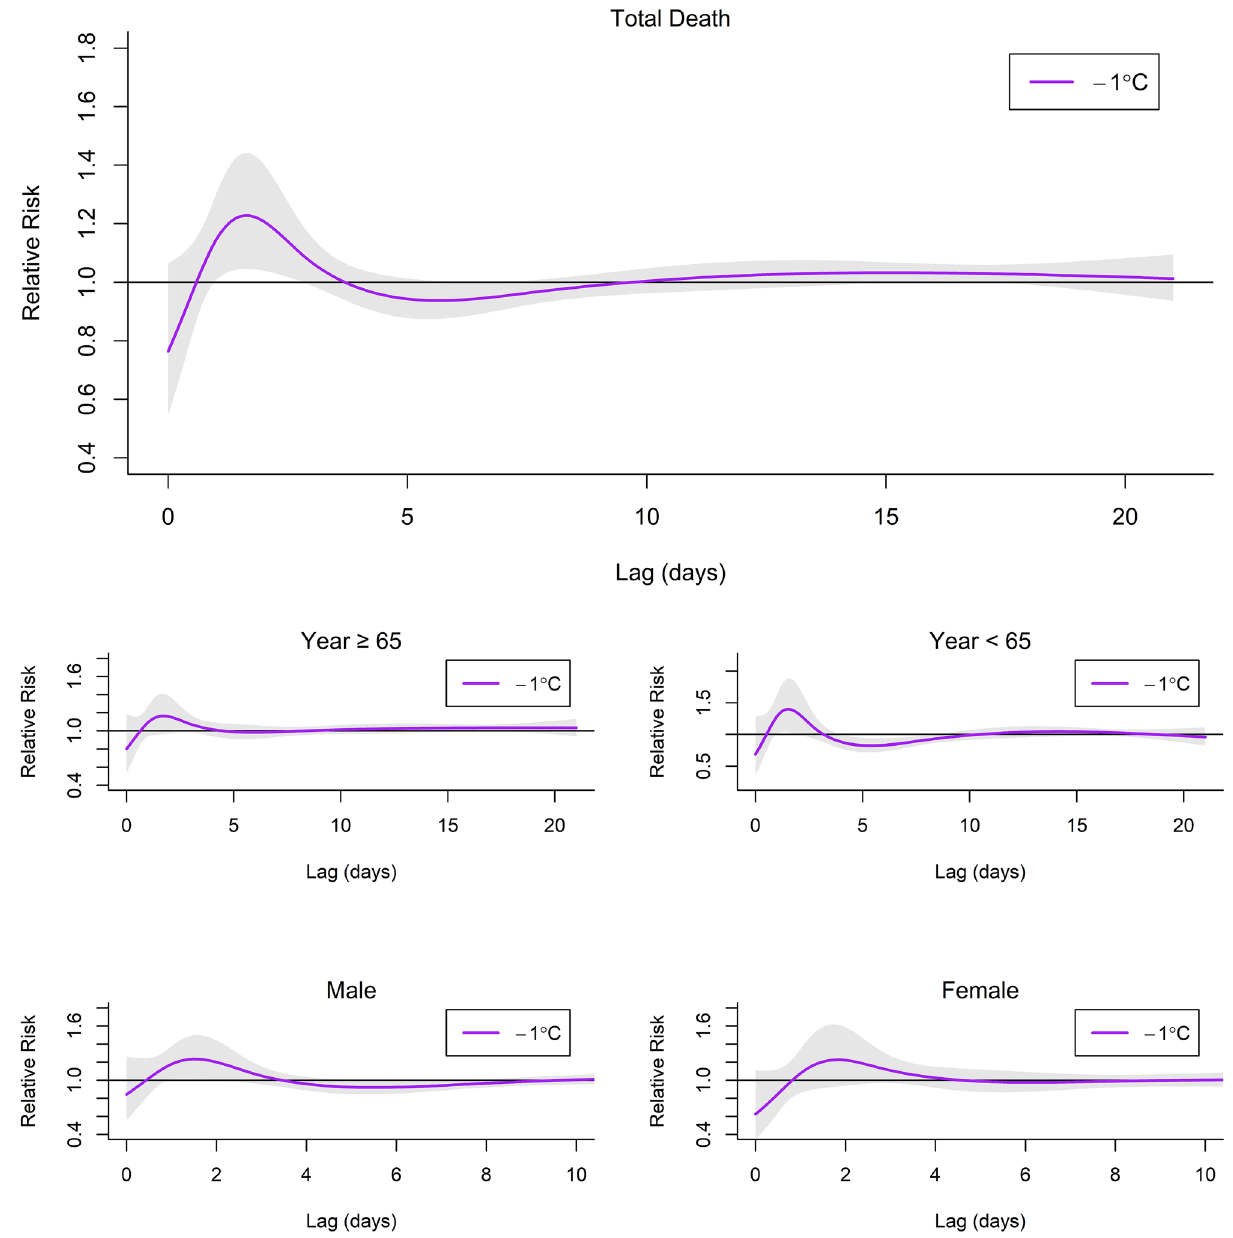
Figure 4. The estimated relative risk of dying on a day with − 1 °C compared with that on a day with 28 °C (MT) over 21 lagged days for all summers (whole study